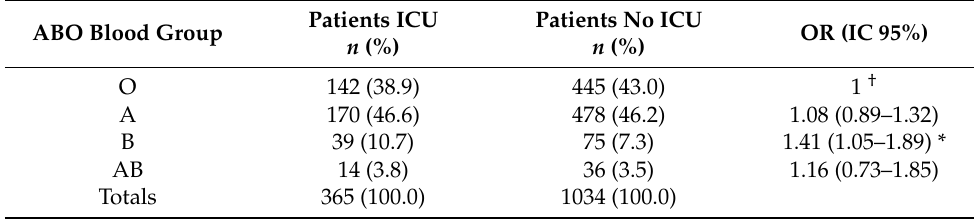
Table 4. Comparison between ABO group distribution in patients with COVID-19 admitted to the intensive care unit (patients ICU) and control group: patients with COVID-19 admitted to the hospital (patients no ICU). * p < 0.05.